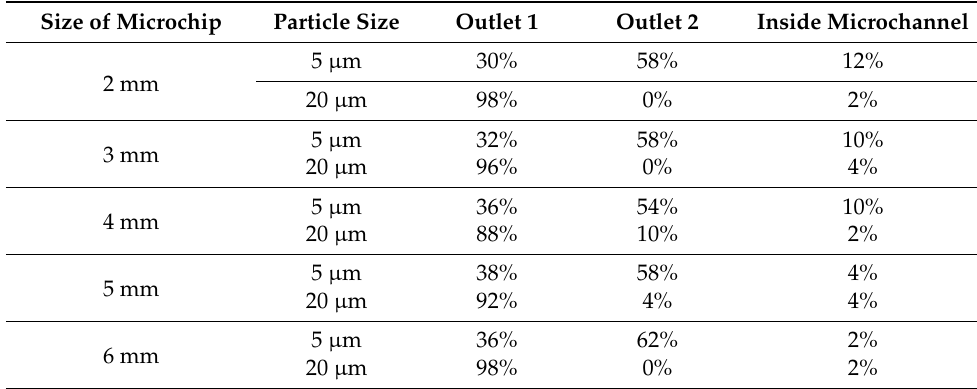
Table 2. Particle capture in various cilia walls